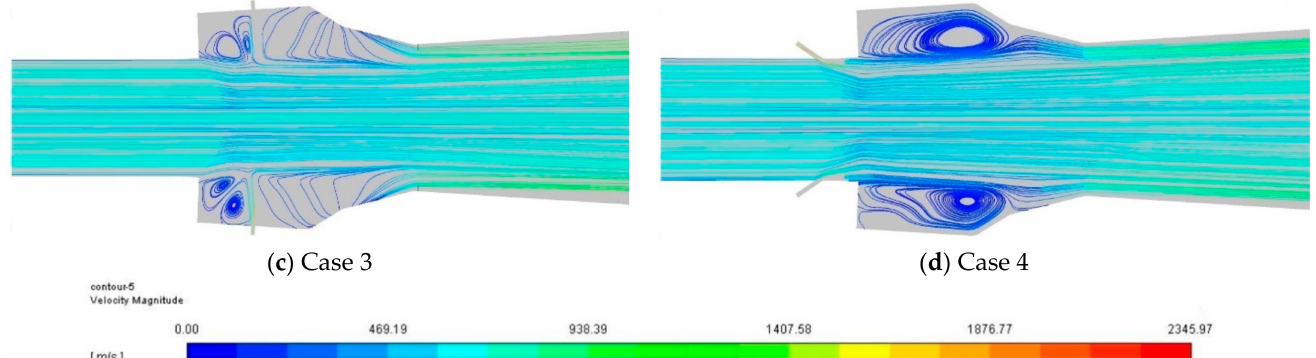
Figure 5. Velocity streamlines of the four injection cases.